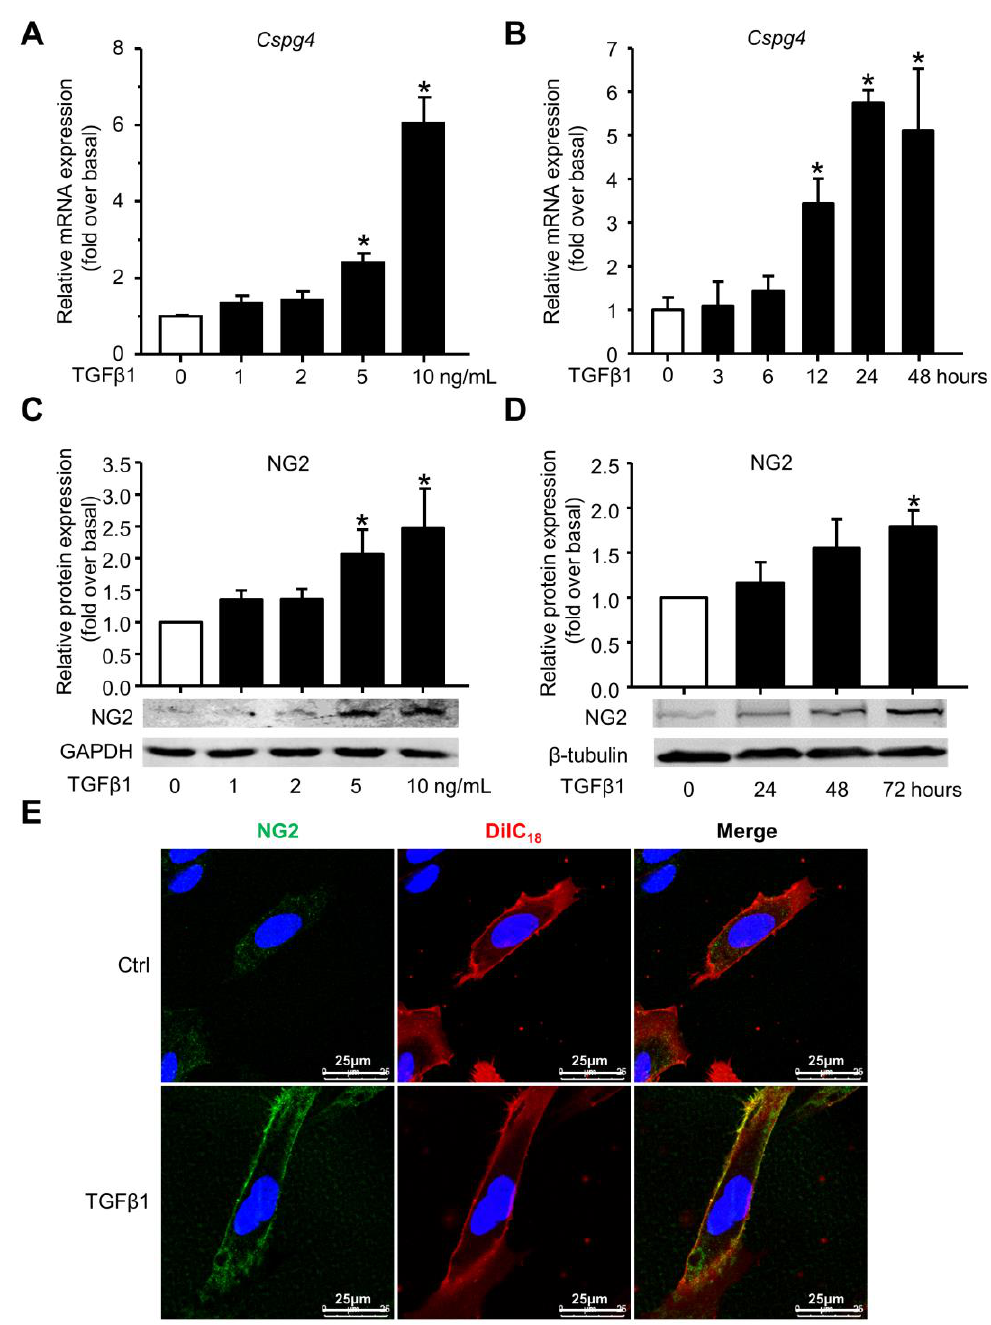
Figure 4. The mRNA and protein expression of NG2 in TGF β 1-induced BMSC differentiation. ( A ) Cspg4 mRNA expression in BMSC treated with the indicated concentrations of TGF β 1 for 24 h. ( B ) Cspg4 mRNA expression in BMSC treated with 10 ng/mL TGF β 1 for different time points. ( C ) NG2 protein expression in BMSC treated with the indicated concentrations of TGF β 1 for 24 h. ( D ) NG2 protein expression in BMSC treated with 10 ng/mL TGF β 1 for different time points. ( E ) Immunofluorescent staining for NG2 (green) in TGF β 1-treated BMSC. Cell membrane was labeled with a membrane dye DiIC 18 (red). DAPI was used to visualize nuclei (blue). Data are presented as the mean ± SEM. n = 3 per group. * p < 0.05 vs. control. 2.5. The Involvement of NG2 in TGF β 1-Induced BMSC Differentiation to MF